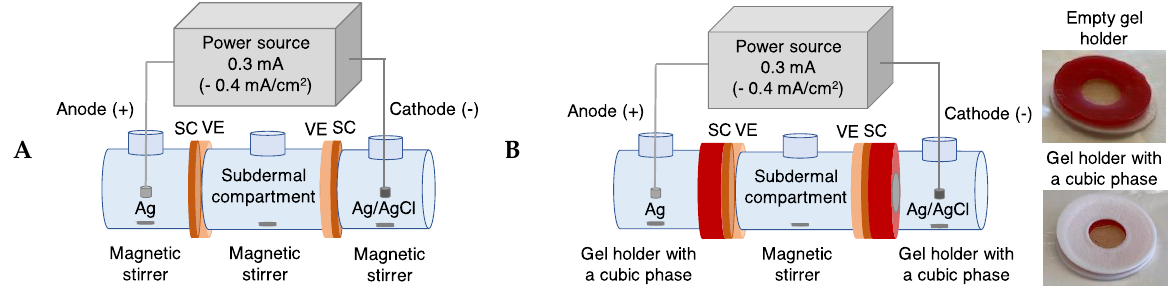
Figure 1. Graphical representation of the reverse iontophoresis experiments with anodal and cathodal receptor phases comprising either ( A ) an aqueous buffer ( n = 5 – 12, see Table 2), or ( B ) a cubic phase in contact with an aqueous buffer ( n = 3 – 5, see Table S7 in Supplementary Materials).